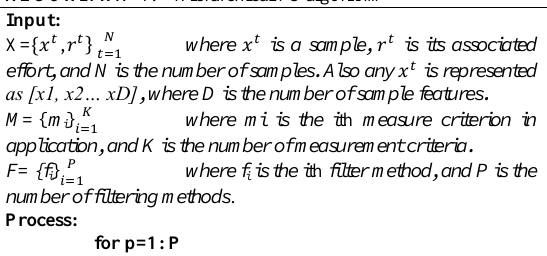
ALGORITHM 1. Hierarchical FS algorithm Input: